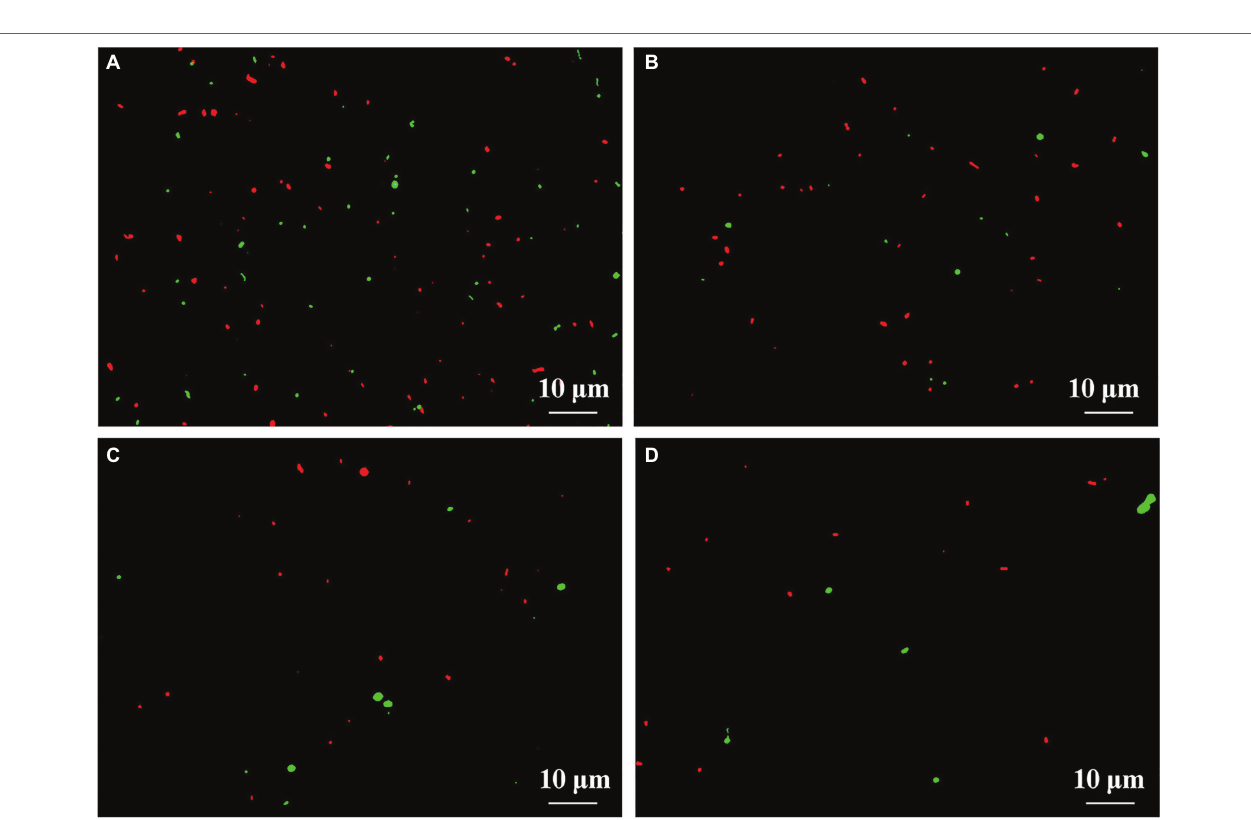
FIGURE 3 | Numbers of gut bacteria in fecal samples from the healthy and attention-deficit hyperactivity disorder (ADHD) children by the plate counting method. Vertical bars represent standard errors of the means ( n = 6). Bars followed by the same letter(s) are not significantly different ( p ≤